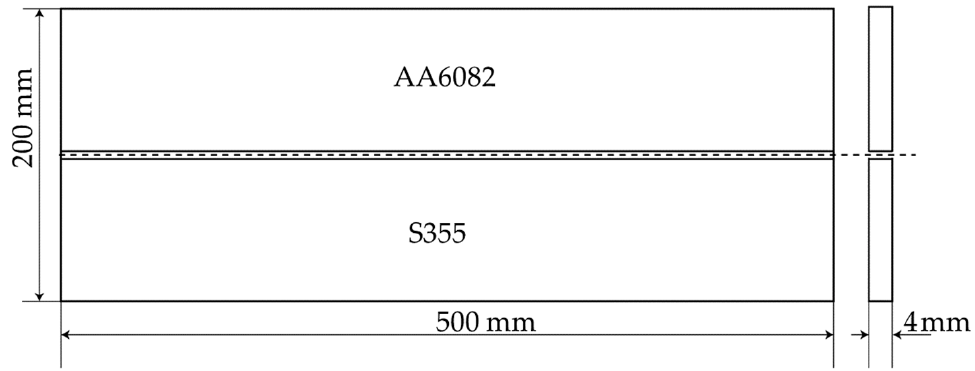
Figure 1. Geometry of the welded plates.